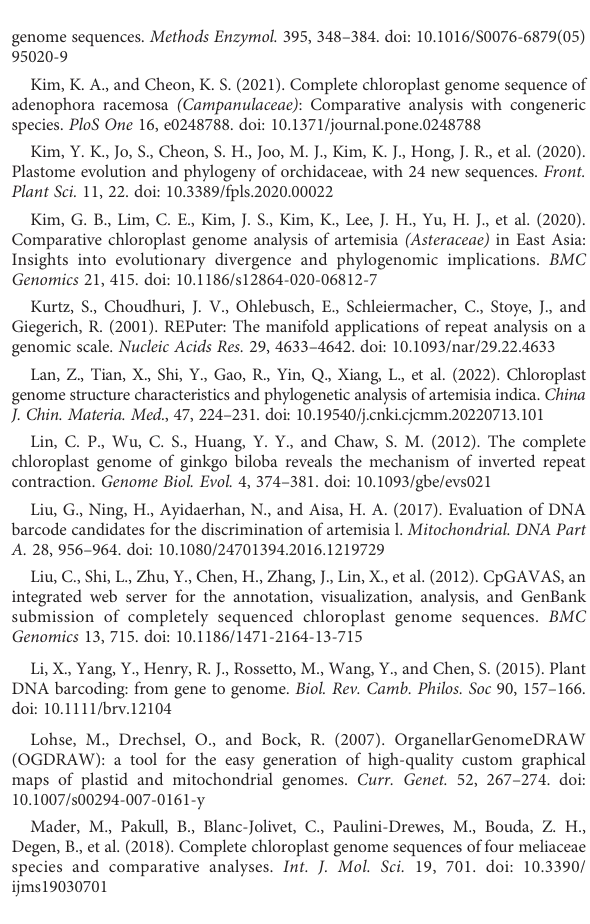
SUPPLEMENTARY TABLE 1 The cp genome information of the fi ve Artemisia